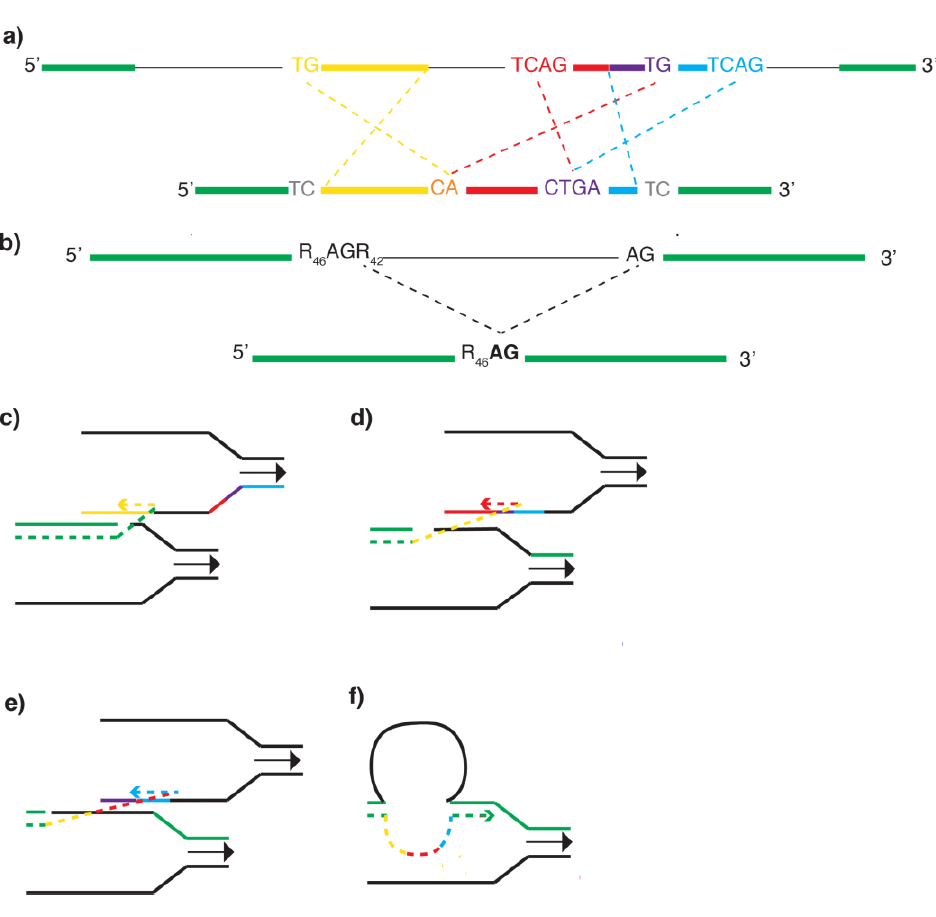
Figure 1. Structure of the recessive red alleles. ( a ) Illustration of the E + (top) and e 1 (bottom) alleles in relation to one another. DNA in the same orientation in green. Deleted DNA as thin black line. TC insertions in grey font. Inversion 1 in yellow, Inversion 2 in red, and Inversion 3 in blue. DNA duplicated in Inversions 2 and 3 in purple. Sequence of microhomologies at the inversion junctions shown. ( b ) Illustration of the E + (top) and e 2 (bottom) alleles in relation to one another. DNA in same orientation in both alleles in green. Deleted DNA as thin black line. Proximal deletion breakpoint is in a run of 90 purines (R), the junction of the deletion forms a microhomology as shown. ( c – f ) Putative replicative mechanism to explain formation of e 1 allele. As replication fork (black) proceeds left-to-right, a lesion in the template strand (break in green line) may cause DNA polymerase to disengage from leading strand template and invade the lagging strand template. FoSTeS event 1 would cause Inversion 1 in yellow. As the replication fork proceeds distally, subsequent disengagement and re-engagement with the lagging strand template would produce Inversion 2 (red, d ) and 3 (blue, e ), before re-engagement with the original template (green, f ) eventually occurs.